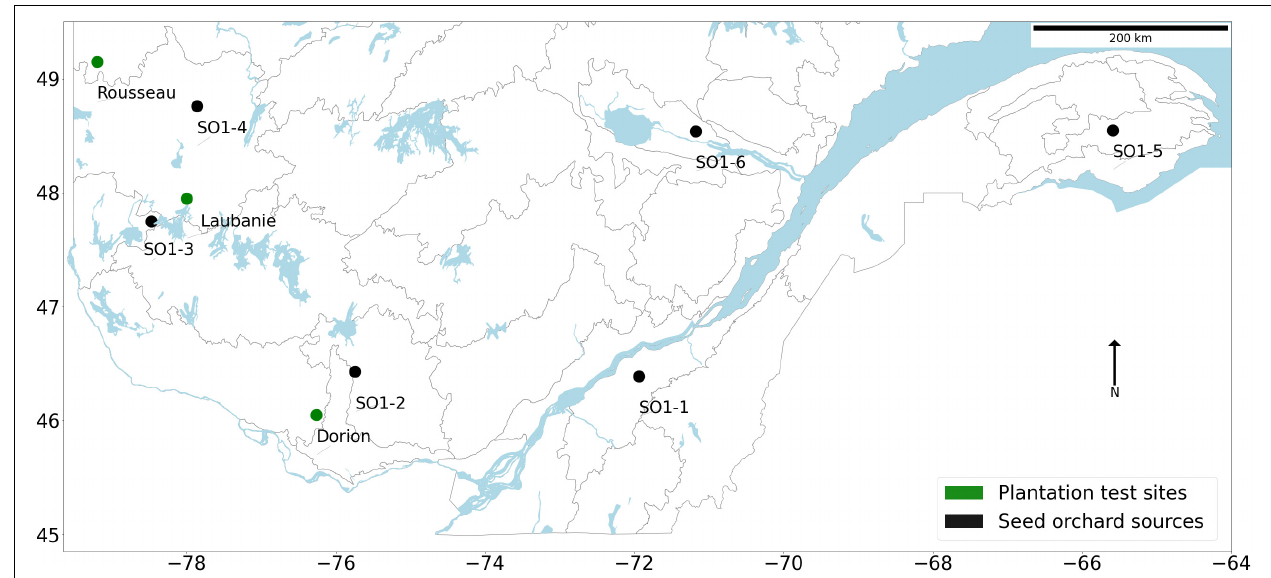
FIGURE 1 | Location of the three plantation test sites (green circles) and their local seed sources, and the six seed sources (black squares) replicated on each test site. The plantations were established in Spring of